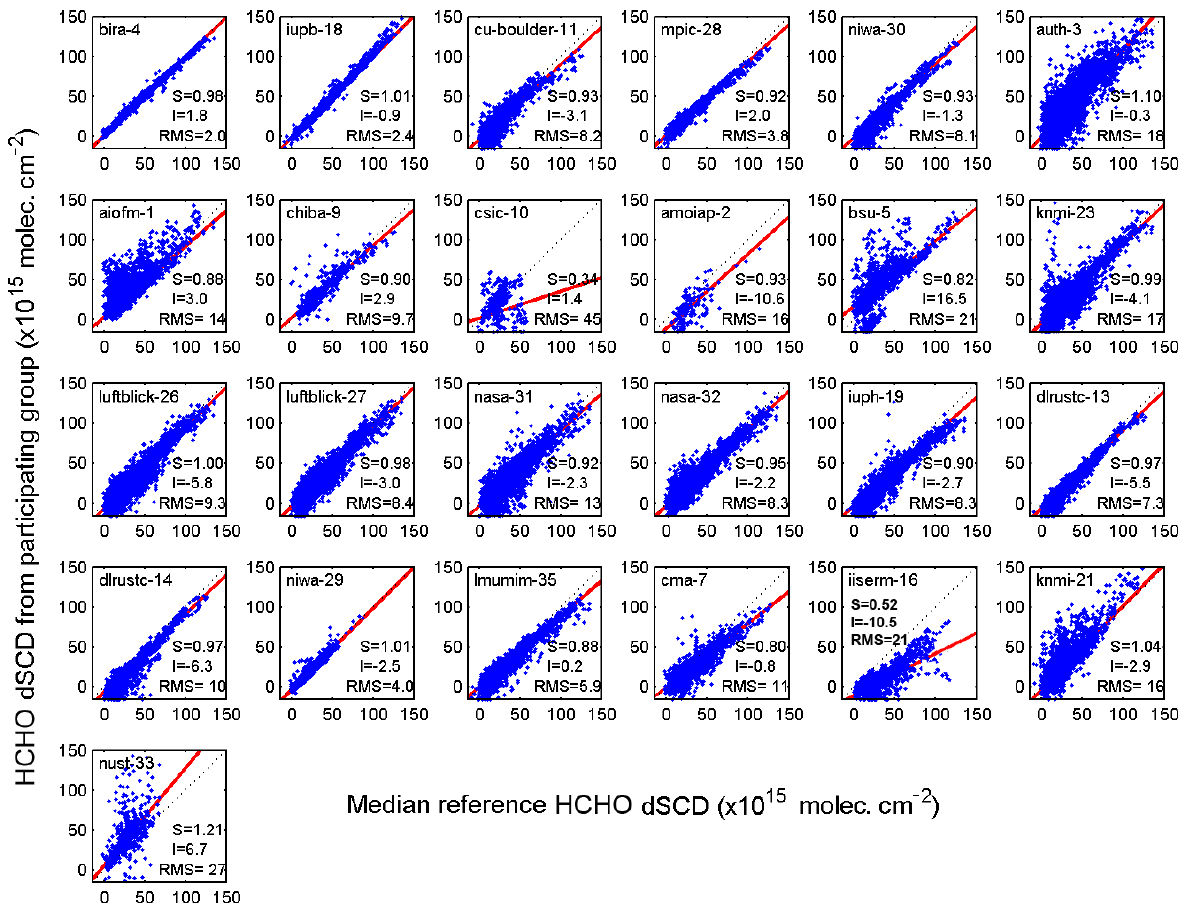
Figure 12. Same as Fig. 10 but for HCHO